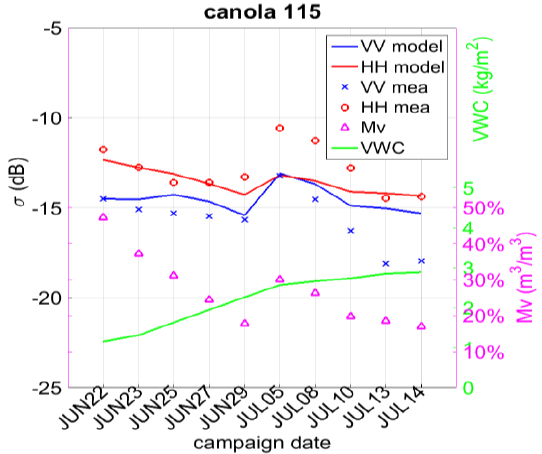
Figure 6. Forward model evaluation for canola field 115. Mv and VWC refers to in situ data. mea denotes in situ measurement.